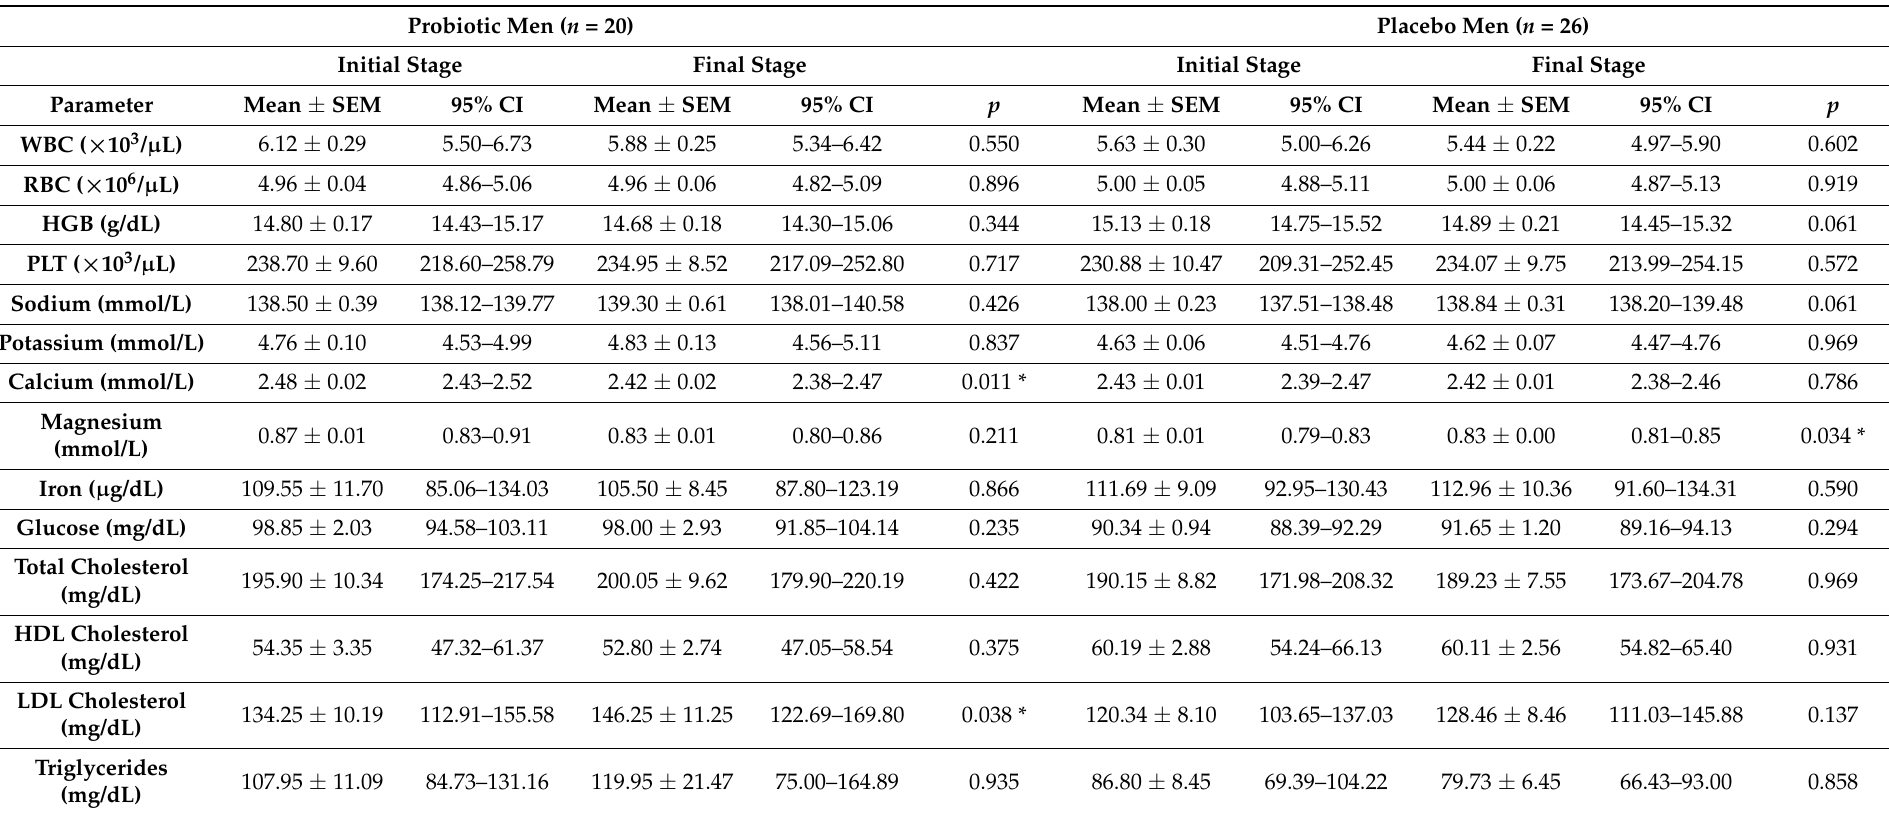
Table 2. Comparison of blood biochemical parameters in men from the probiotic and placebo groups at the initial and final stages of the study. * Statistical significance ( p < 0.05) determined between the initial and final